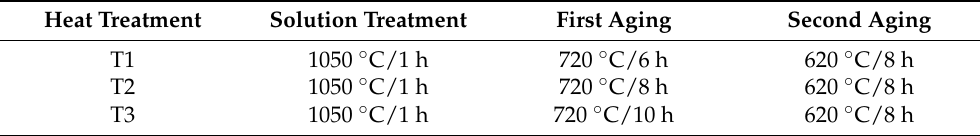
Table 2. Heat treatments applied to cellular structures of additively manufactured IN718.